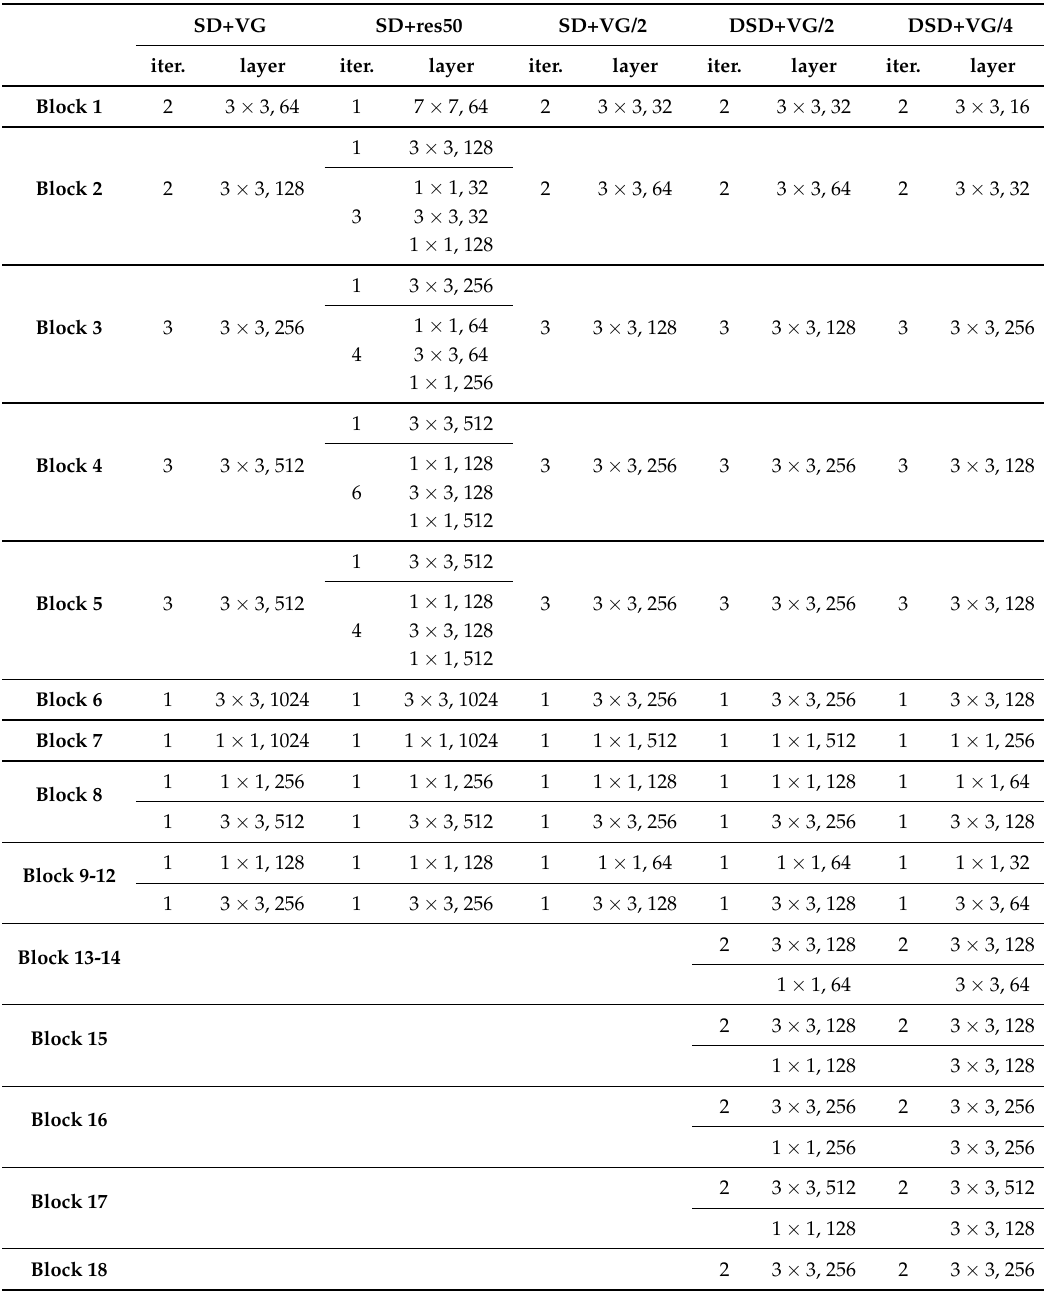
Table 1. Layer specification of each network